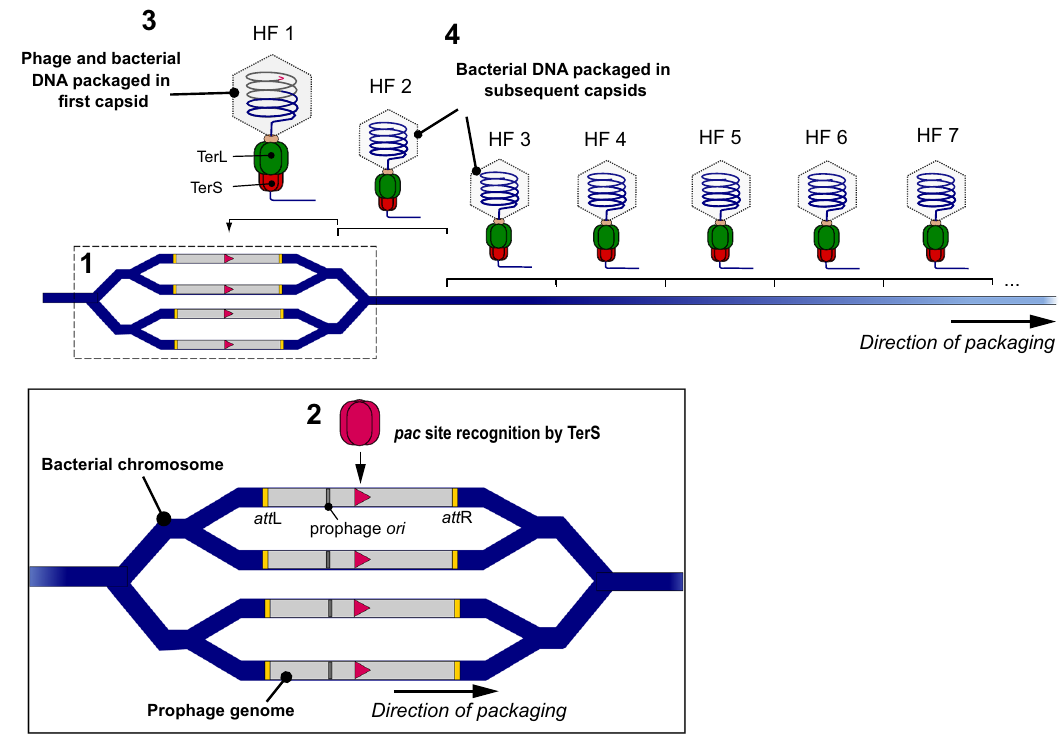
Fig. 1 Lateral transduction of chromosomal DNA. LT is initiated during the early stages of prophage activation with the prophage remaining integrated in the bacterial chromosome. The mechanism commences with bidirectional in situ replication of the integrated prophage from the phage ori , generating multiple copies of the integrated phage and surrounding bacterial chromosome [1]. Some prophages subsequently excise from the chromosome to generate progeny via the lytic cycle, but in those that remain integrated, the phage small terminase subunit (TerS) recognises the embedded pac site (pink triangle) within the prophage sequence, forming a complex for delivery of the DNA to the large terminase (TerL) subunit [2]. The TerS:DNA complex associates with the large terminase (TerL) subunit, which cleaves and translocates the DNA into available phage capsids until capacity (one headful) is reached, with the initial capsid containing a mixture of phage and chromosomal DNA [3]. When the capsid is fi lled, the DNA is cleaved once more and the Terminase:DNA complex associates with a new empty capsid to resume the packaging process, generating many processive headfuls containing bacterial chromosomes for subsequent transduction